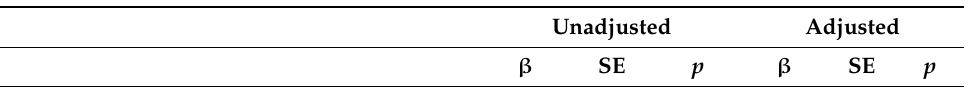
Table 3. Unadjusted and Adjusted Linear Regression Analytic Findings Exploring Associations with FV purchasing (also adjusts for recruitment